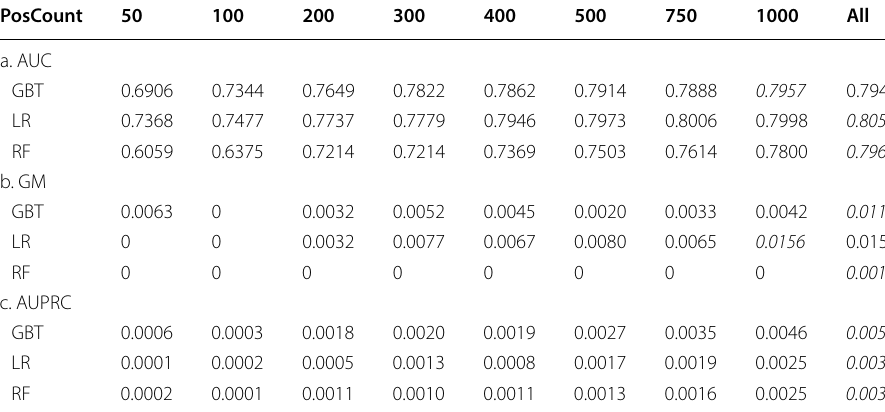
Table 3 Medicare Part B average results